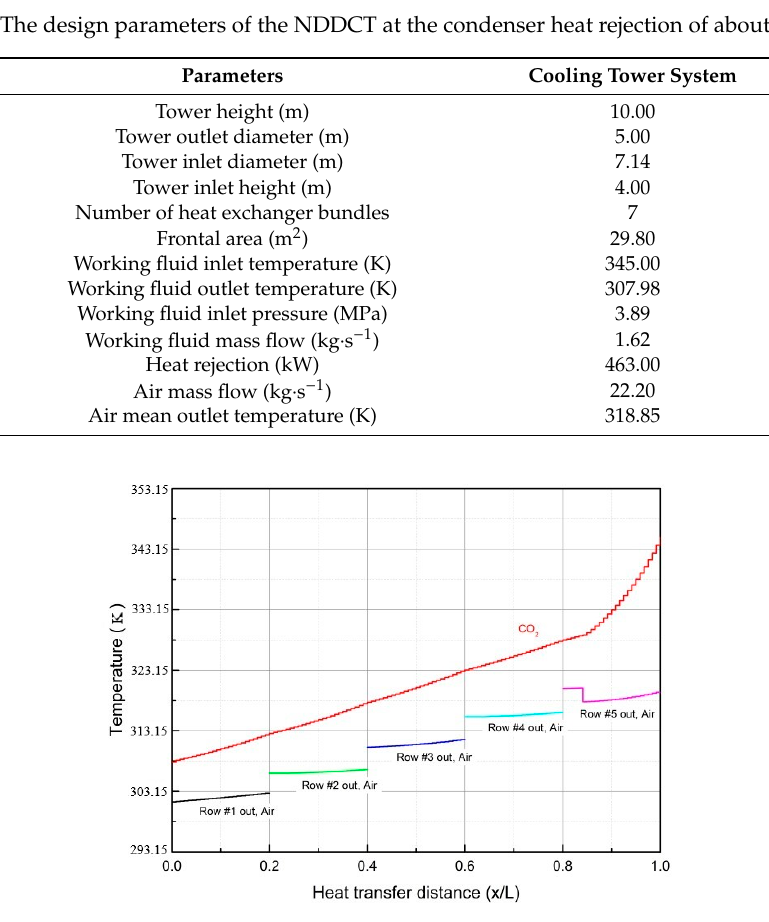
Figure 10. Temperature profile in the cooling tower.